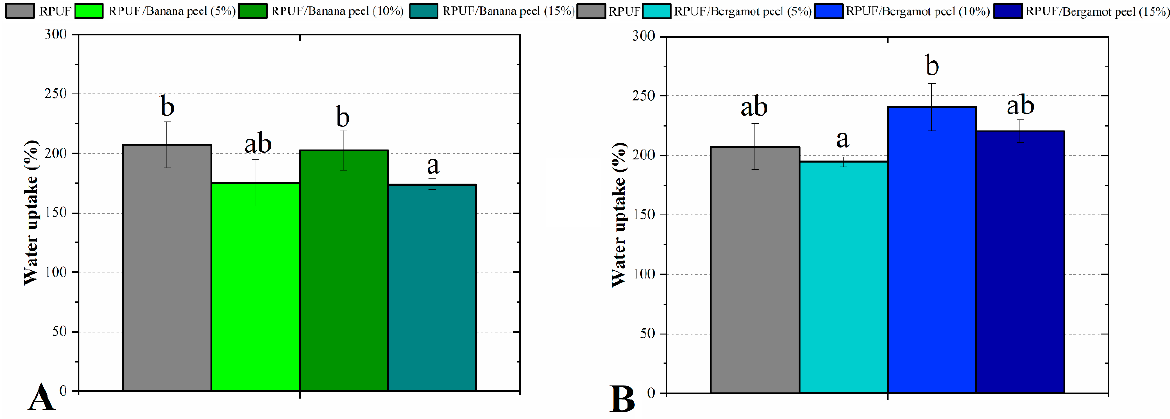
Figure 8. Water uptake of the studied RPUF with Banana peels ( A ) and Bergamot peels ( B ). RPUF is the neat rigid polyurethane foam and filler type, and filler content is the numbers after the bars and between parentheses, respectively. Different letters represent statistically different means.